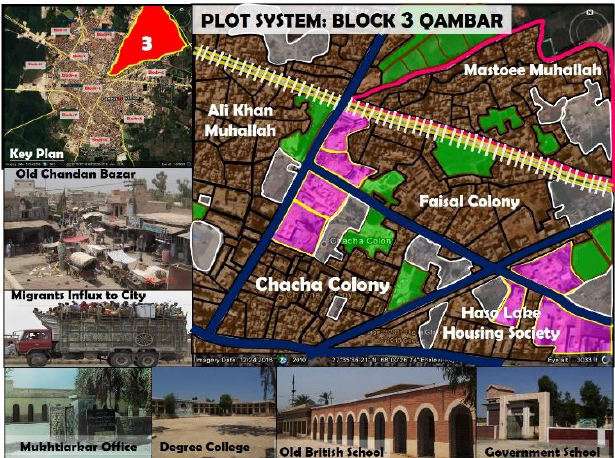
Fig. 7. Town plan analysis of Qambar: plot system and its pattern in urban block 3 Fig. 9. Image-ability analysis of Qambar: The elements of city paths, edges, and districts in urban block 5 From urban design viewpoint paths are the outcome of space between buildings and edges are defined by primary and secondary roads. Block 6 of Qambar has three neighbourhoods of ‘Bagodero’, ‘Sonara Muhallah’ and ‘Harijan colony’ (see Fig. 10) with major activity nodes and landmarks i.e., Obelisk tower, Bagodero school, and new Civil Hospital etc.